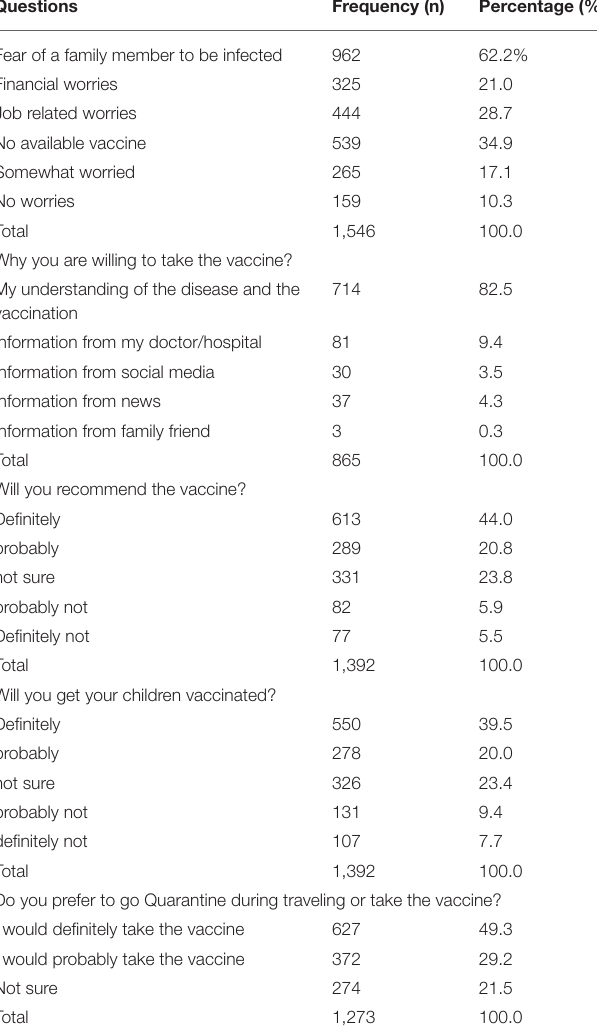
TABLE 2 | Intention to accept vaccine, health conditions, worries about COVID-19, and general attitude toward